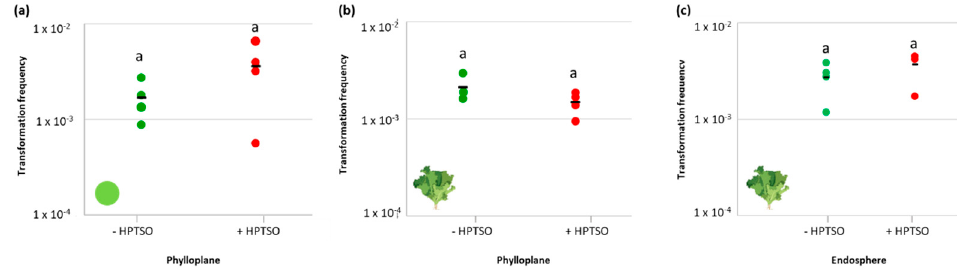
Figure 4. Influence of the heptamethyltrisiloxane surfactant on the natural transformation of A. baylyi BD413. Transformation frequency of A. baylyi BD413 with 10 ng of plasmid pZR80(gfp) on leaf disc ( a ) and in planta ( b ) in the presence (+HPTSO) or absence (-HPTSO) of the surfactant molecule heptamethyltrisiloxane. Panel ( c ) indicates the ratio between transformant and total A. baylyi BD413 colonies reisolated from the leaf endosphere. The black line indicates the average value of four biological replicates. The same letter (a) indicates no significant differences between the values detected in the presence or absence of HPTSO (Student’s t -test, p -value > 0.05). The experiment was repeated in planta to reisolate total and transformant colonies of A. baylyi BD413 from the leaf endosphere and measure their ratio in the presence and × 10 − 3 ± 1.33 × 10 − 3 and 2.71 × 10 − 3 ± 1.11 × 10 − 3 , respectively, Student’s t -test, p = 0.2919).